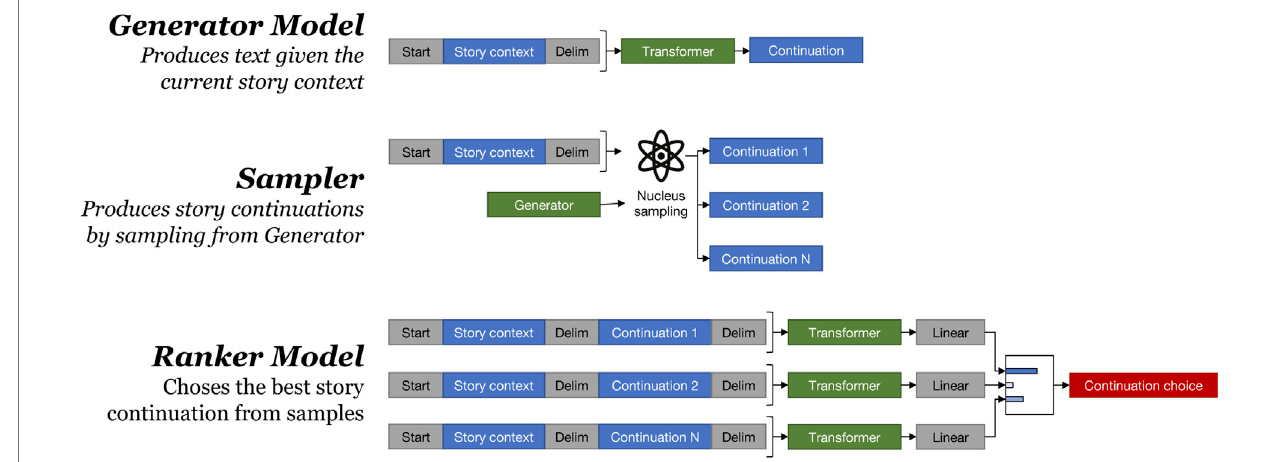
FIGURE 2 | Our collaborative storytelling system architecture.